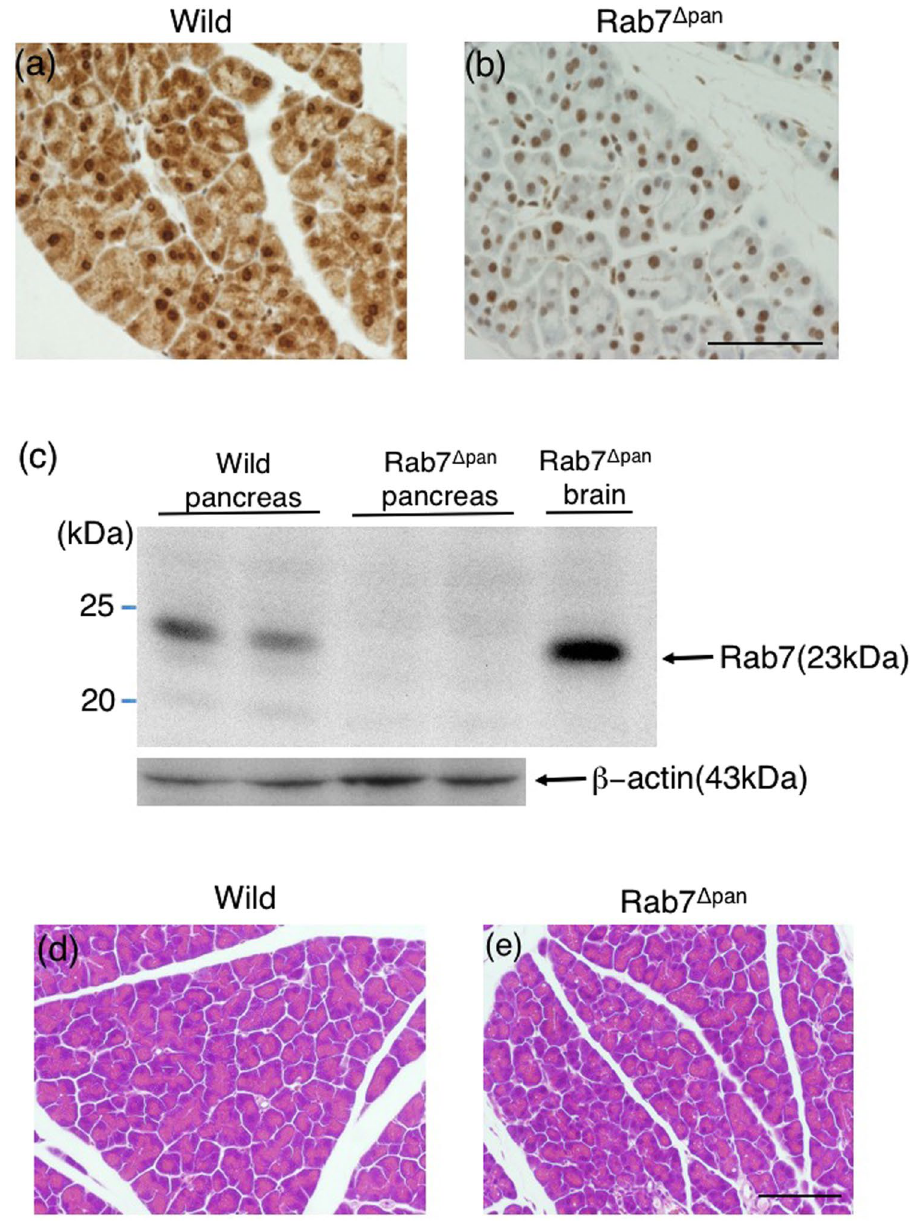
Rab7 Δ pan ( b ) mouse pancreases. Scale Bar: 50 µ m. ( c ) WB of Rab7 using total tissue homogenates of Rab7 Δ pan pancreas and brain and wild mouse pancreas. ( d , e ) HE staining of pancreases of control and Rab7 Δ pan mice. Scale Bar: 50 µ